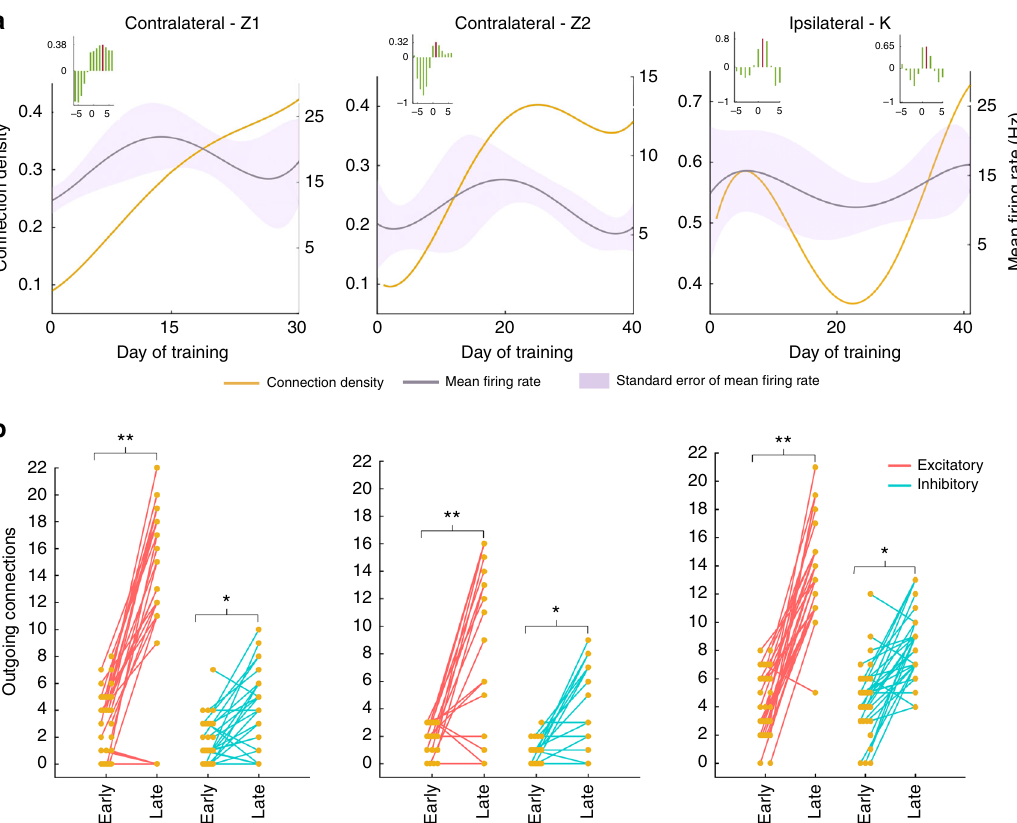
Fig. 5 Relationship between connectivity and fi ring rate. a shows the mean fi ring rate (gray line; the standard error is shown as shaded region) along with the overall connectivity (yellow line). Inset shows the cross-correlation between mean fi ring rate and the normalized connectivity. The peak correlation is marked in red line. b Connection density projecting out of each neuron (i.e., out-degree density) during an early pooled data set and a late learning day is shown. The early pooled and late data sets had comparable spike counts. Each point corresponds to the number of out-degree connections of a single neuron. Red and blue lines connect excitatory and inhibitory out-degree densities, respectively. (Paired t-test, ** p < 0.01, * p <